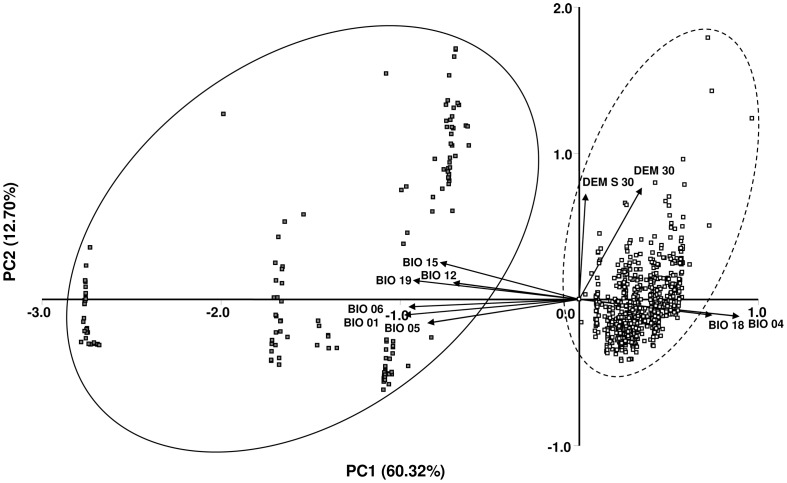
Plot of PCA based on ten environmental variables describing 802 Fraxinus angustifolia localities.The Continental (white squares) and Mediterranean (grey squares) ecological lineages were separated along the PC1 and PC2. See Table 2 for environmental variable codes.